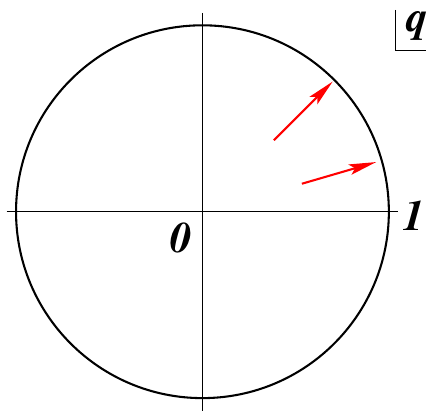
Z , enters many aspects of our story: the Kazhdan- Figure 4 . The limit q e 2 (cid:25)i=k , with k ! 2 Lusztig correspondence, the relation between b Z a ( M 3 ) and WRT invariants, the relation between mock modular forms and false thetas,